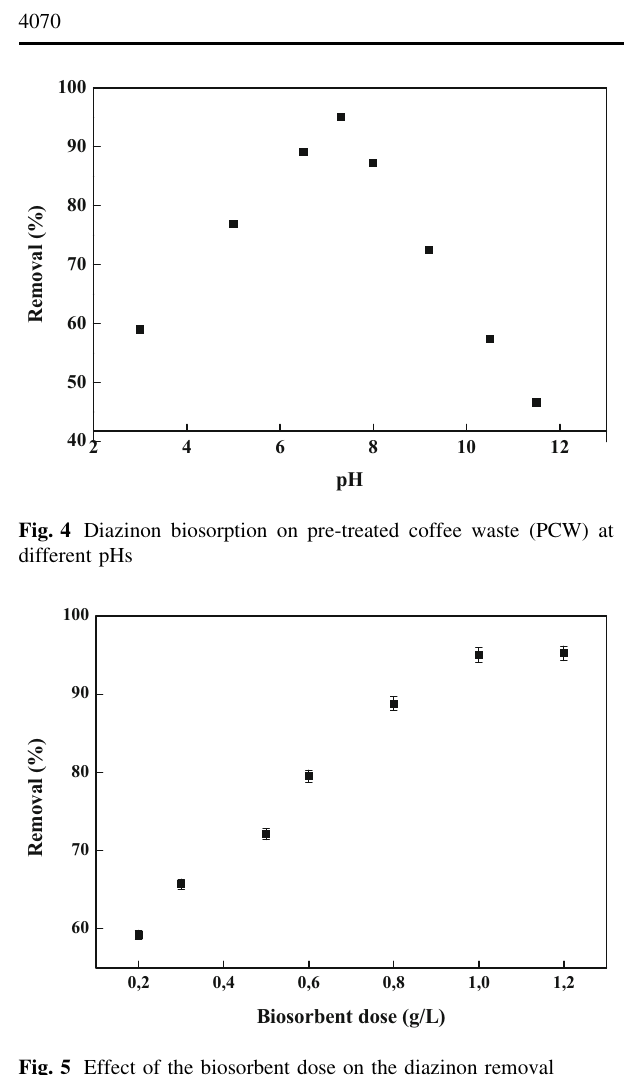
Fig. 5 Effect of the biosorbent dose on the diazinon removal